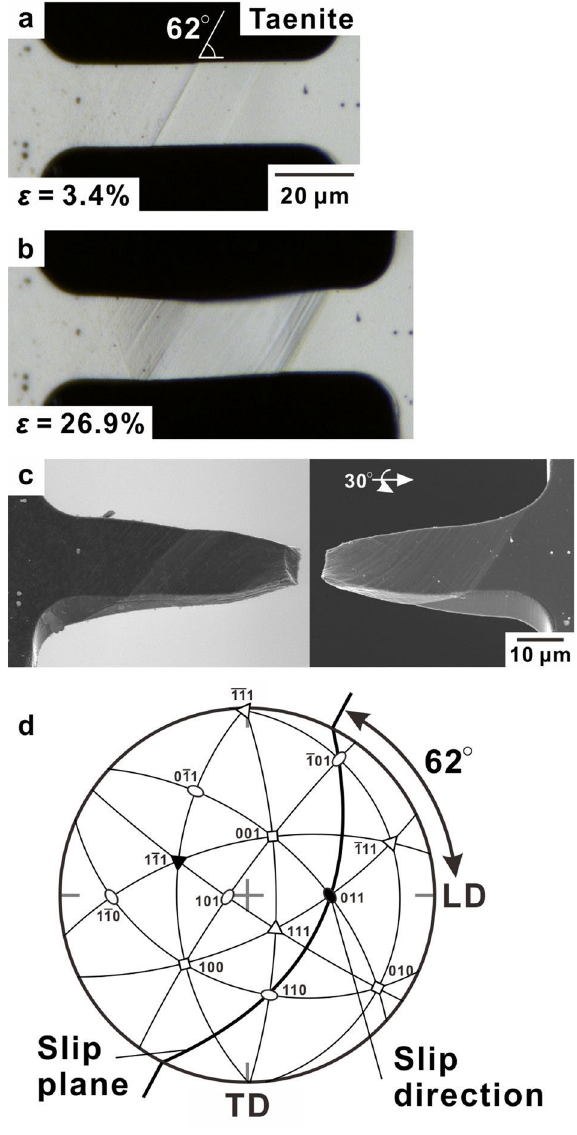
Figure 4. Deformation and fracture behaviour in the single-crystalline taenite specimen. ( a , b ) Optical micrographs captured during deformation at nominal strains, ε , of 3.4% and 26.9%, respectively. ( c ) Scanning electron microscopy image showing the fracture morphology. ( d ) Stereographic projection of the taenite specimen in the initial state with related slip